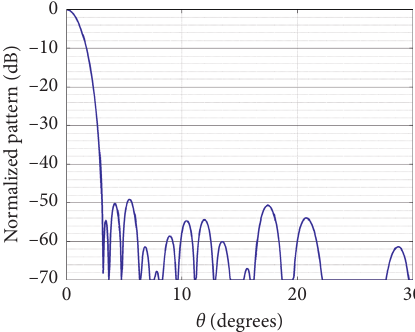
Figure 12: The two-way array pattern for N � 38 r M � 45. SLL �− 49.4dB.